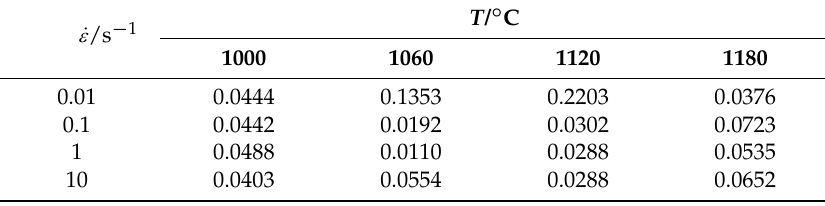
Table 4. The relative error ( ARRE ) between theoretical and corrected experimental.